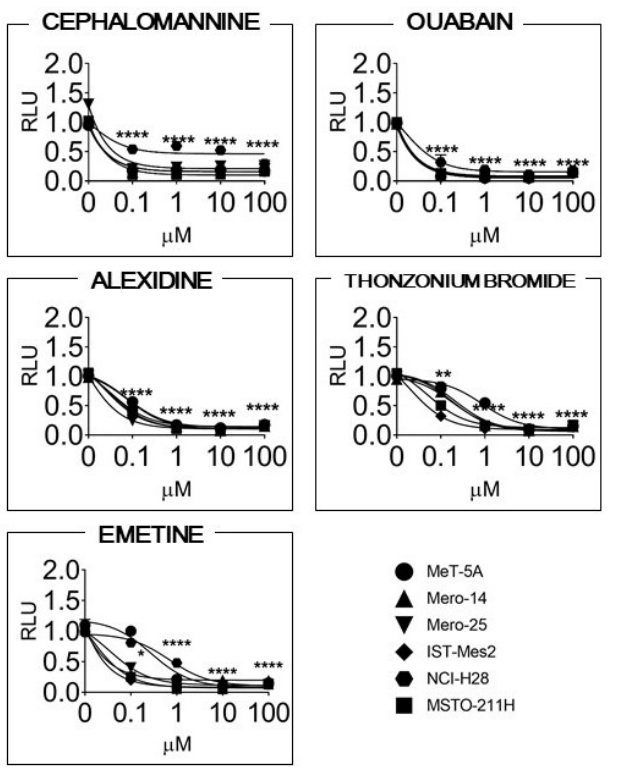
Figure 1. Cell viability, expressed as relative luminescence units (RLU) (i.e., the luminescence relative to the controls) and measured at 72 h after treatment of the cells with the doses of 0, 0.1, 1, 10, and 100 μ M of each compound. Three independent experiments, each performed in triplicate, were carried out. Dots represent the means, their size, and the SEM. Asterisks (*) represent the statistical significance of the comparison between the considered dose and the control, where * = p < 0.05; ** = p < 0.01; *** = p < 0.001, and **** = p < 0.0001 .